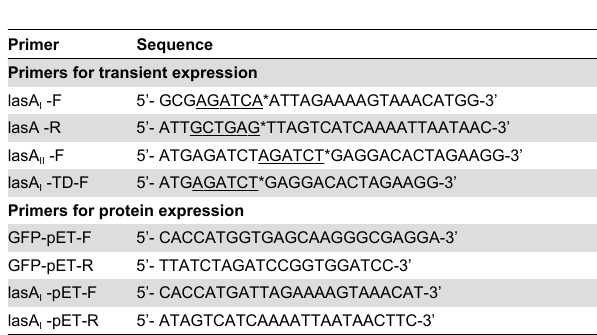
Table 2. Primers used in this